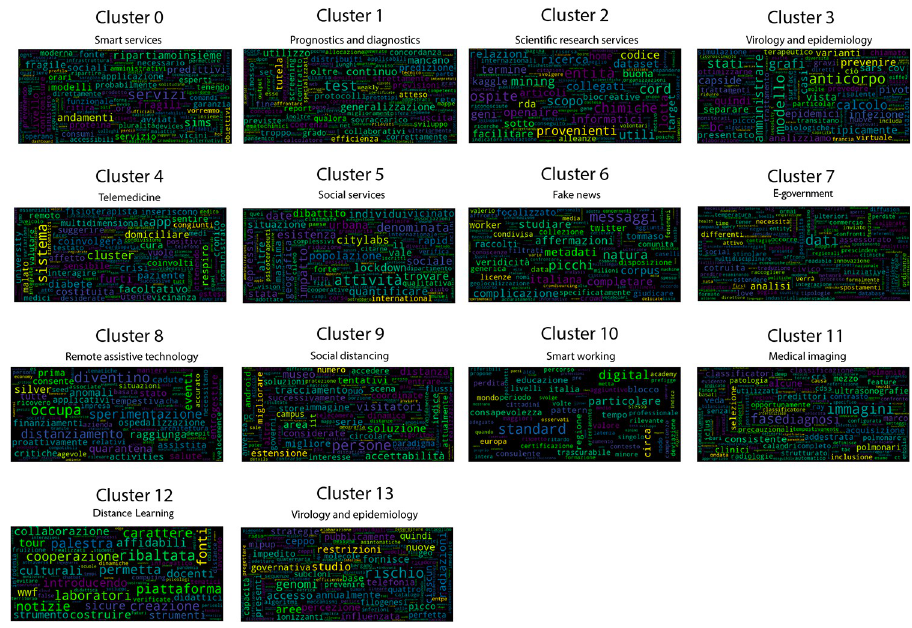
Fig 30. Tag-cloud of clusters for CONF-1.